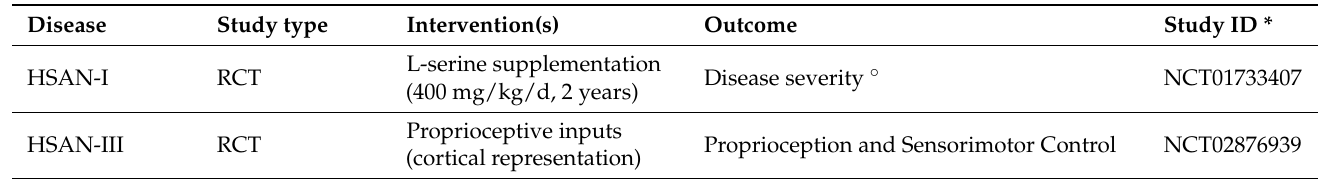
Table 4. Ongoing clinical investigations on hereditary sensory and autonomic neuropathies.